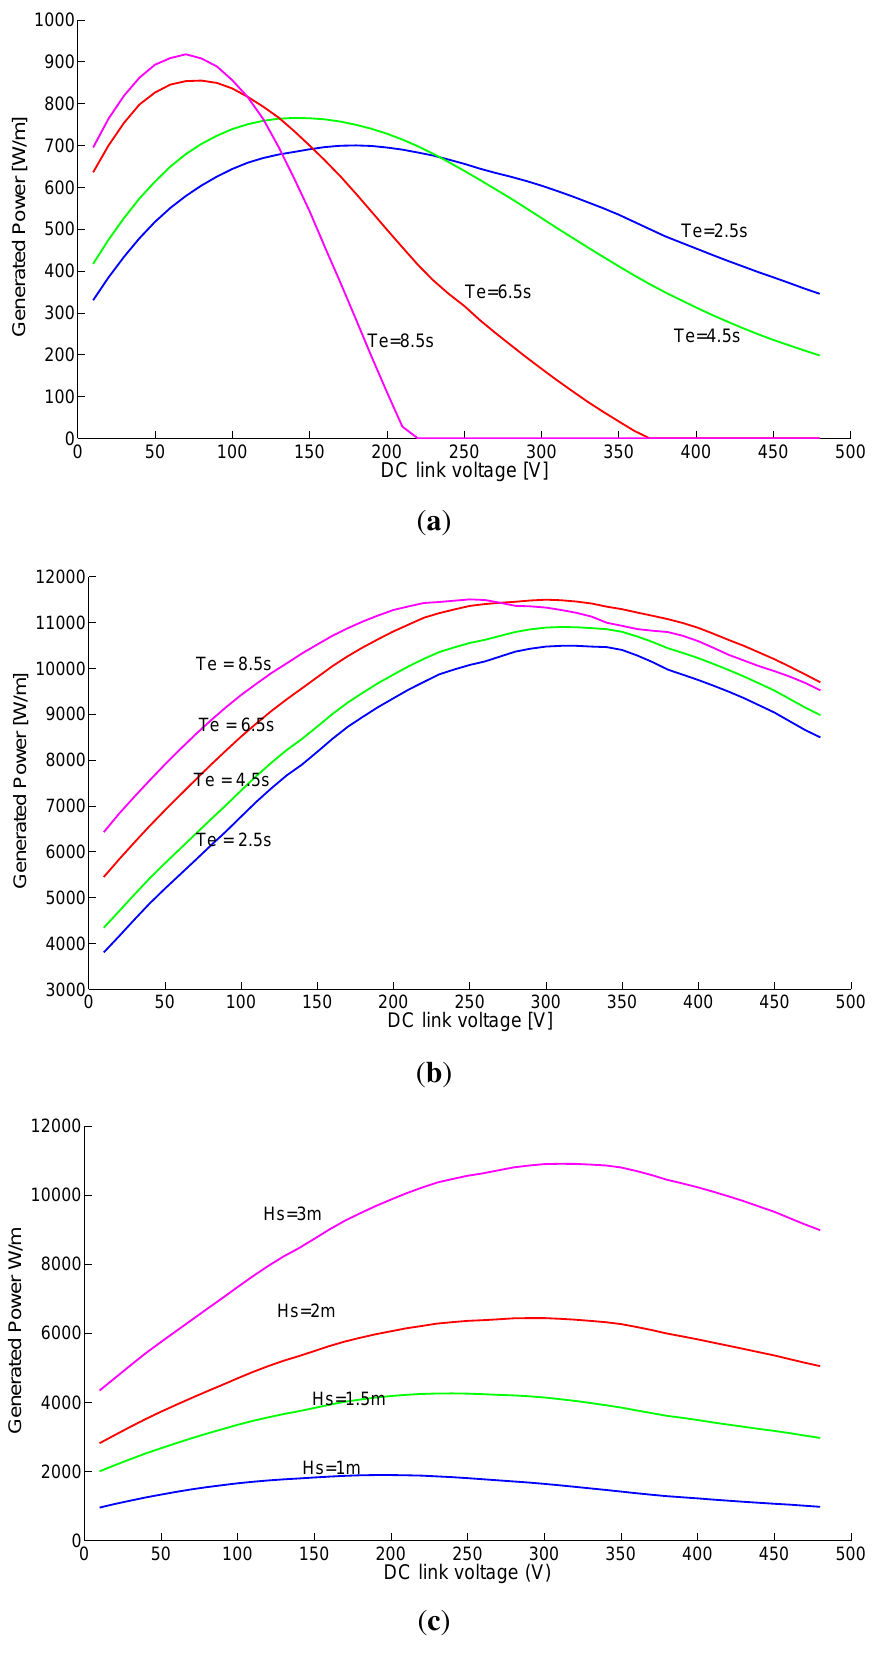
Figure 8. Optimal DC-level keeping either H ( b ) H = 3.0 m; ( c ) T S